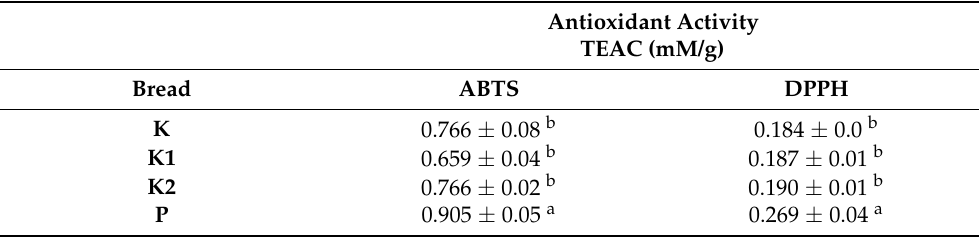
Table 4. Antioxidant properties of bread with S. cerevisiae supplemented with magnesium ions. Control samples: K, dry yeast; K1, without magnesium and PEF treatment; K2, with magnesium and without PEF treatment; P, with magnesium and PEF